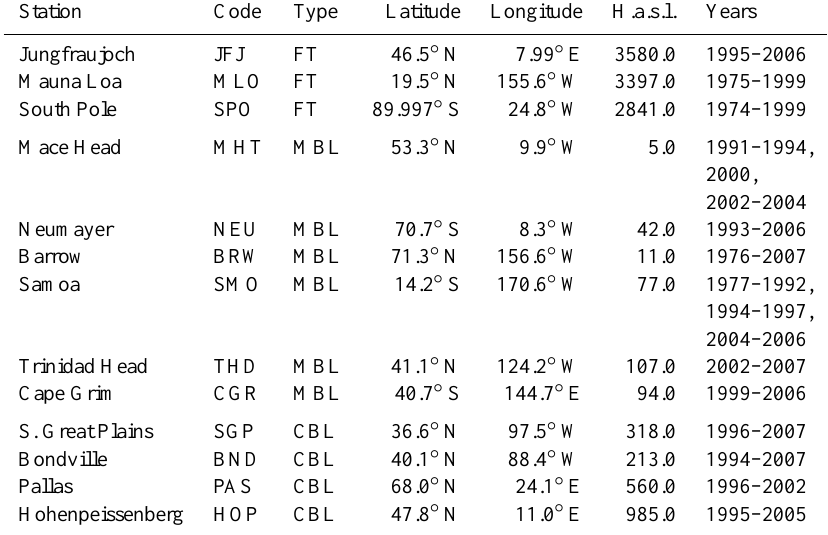
Table 7. Global Atmospheric Watch (GAW) sites used in the comparison against CN concentrations. Sites are categorized as either free troposphere (FT), marine boundary layer (MBL) or continental boundary layer (CBL). The condensation nuclei counters at Cape Grim and Hohenpeissenberg had cut-off diameters of 3nm whilst observed CN at all other sites refer to particles larger than 10nm. All data